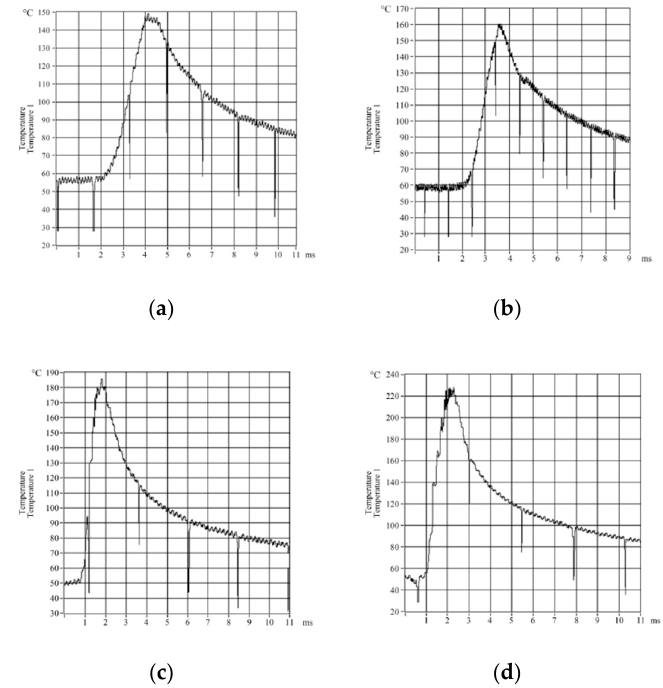
Figure 2. Curves for changes in milling temperature over time at different cutting speeds. ( a ) v c = 120